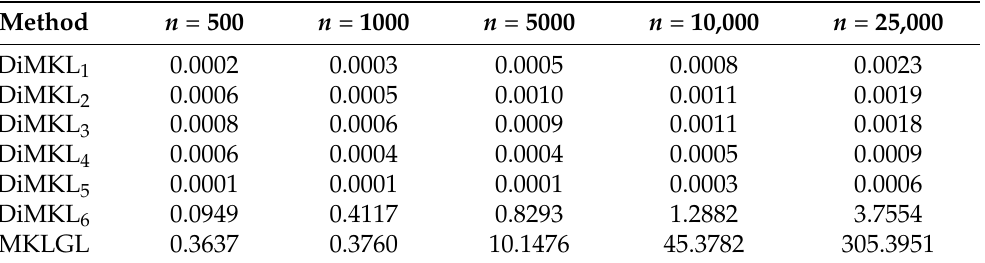
Table 10. Computational complexity: empirical study (reported in seconds); n represents the size of the